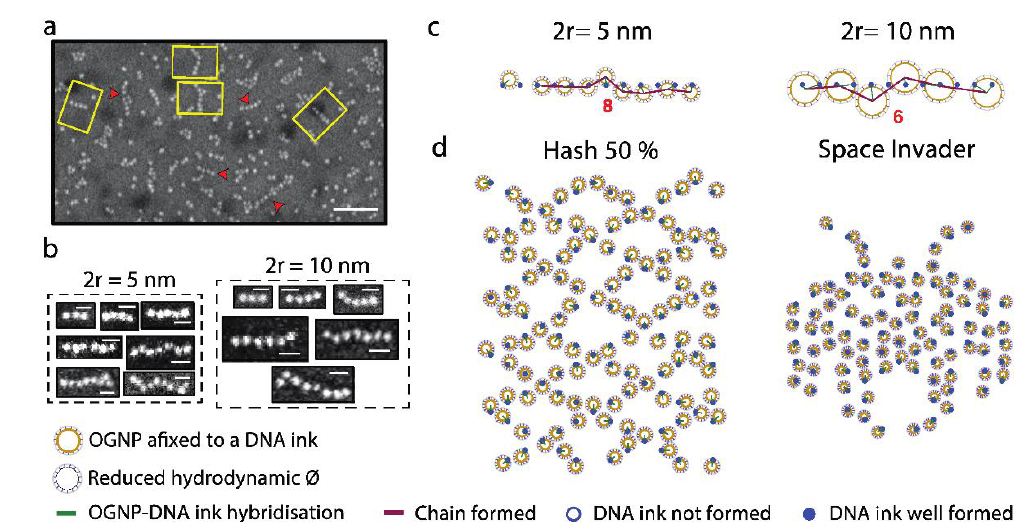
Figure 2. Experimental data and Monte Carlo simulations after Development step. ( a ) SEM image of 10 nm OGNP aligned with the DNA-origami stamp method. The yellow rectangles depict the DNA- origami stamp frame domain (100 nm × 70 nm). The red arrowheads point some OGNP chain alignment. Scale bar: 100 nm. ( b ) SEM images corresponding to different chain classes (i.e., different numbers of OGNP aligned in a chain using 5 and 10 nm particles. 2r indicates the diameter of the gold nanoparticles. Scale bars: 20 nm ( c ) Selected results of CFS using 5 and 10 nm OGNP. The centres of the OGNP have been linked with a violet line to highlight the chain paths formed. The figures in red indicate the number of OGNP contained in the chain. ( d ) Monte Carlo PFS simulations of the development of the indicated DNA ink patterns using 4 nm (hash 50%) and 3 nm (space invader)